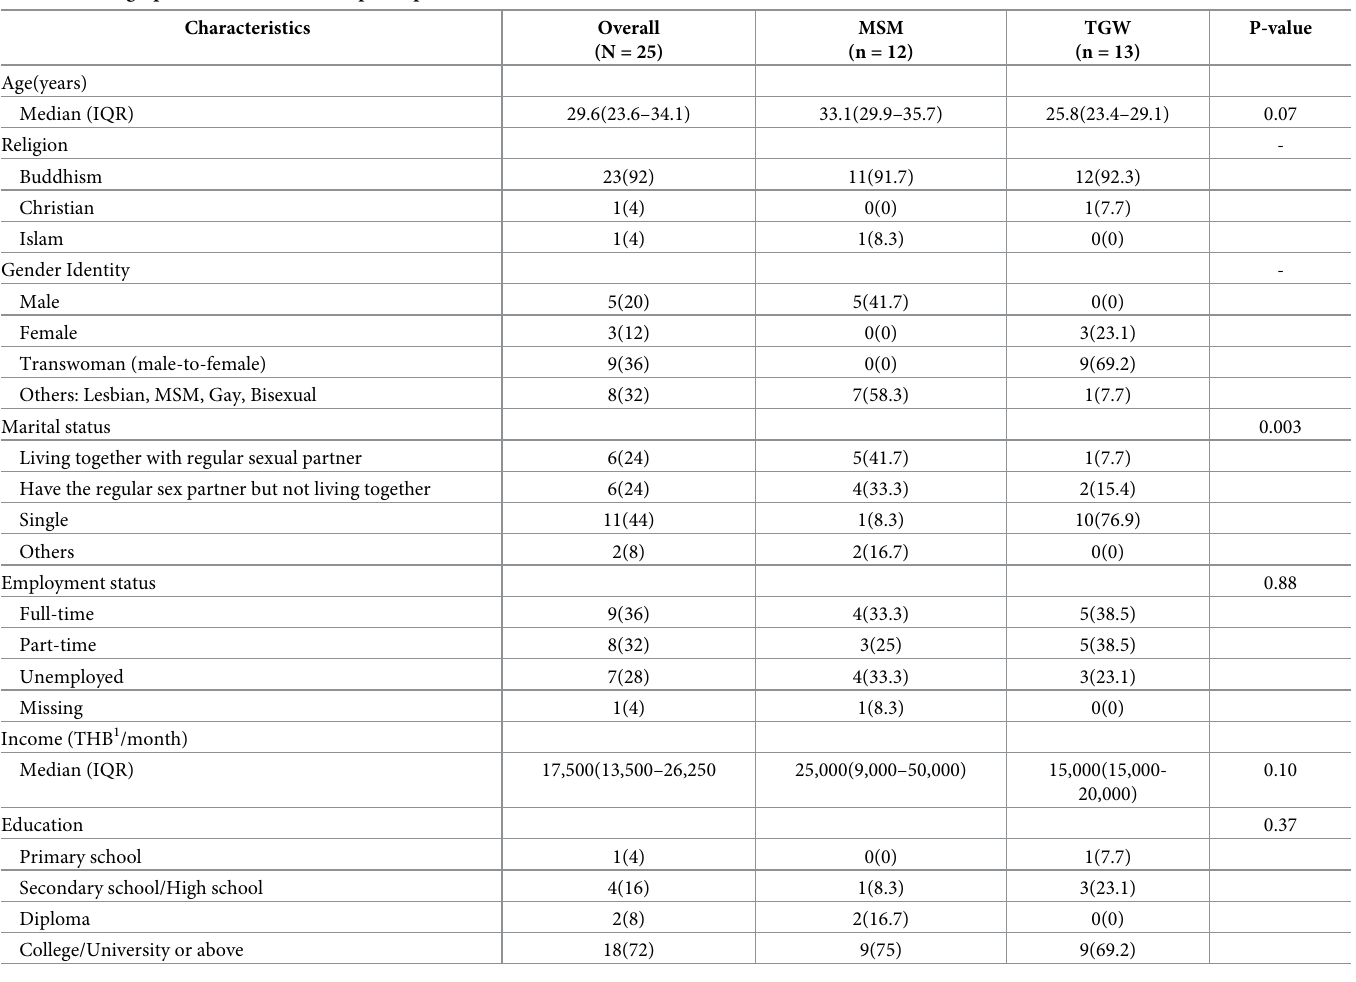
Table 1. Demographics of MSM and TGW